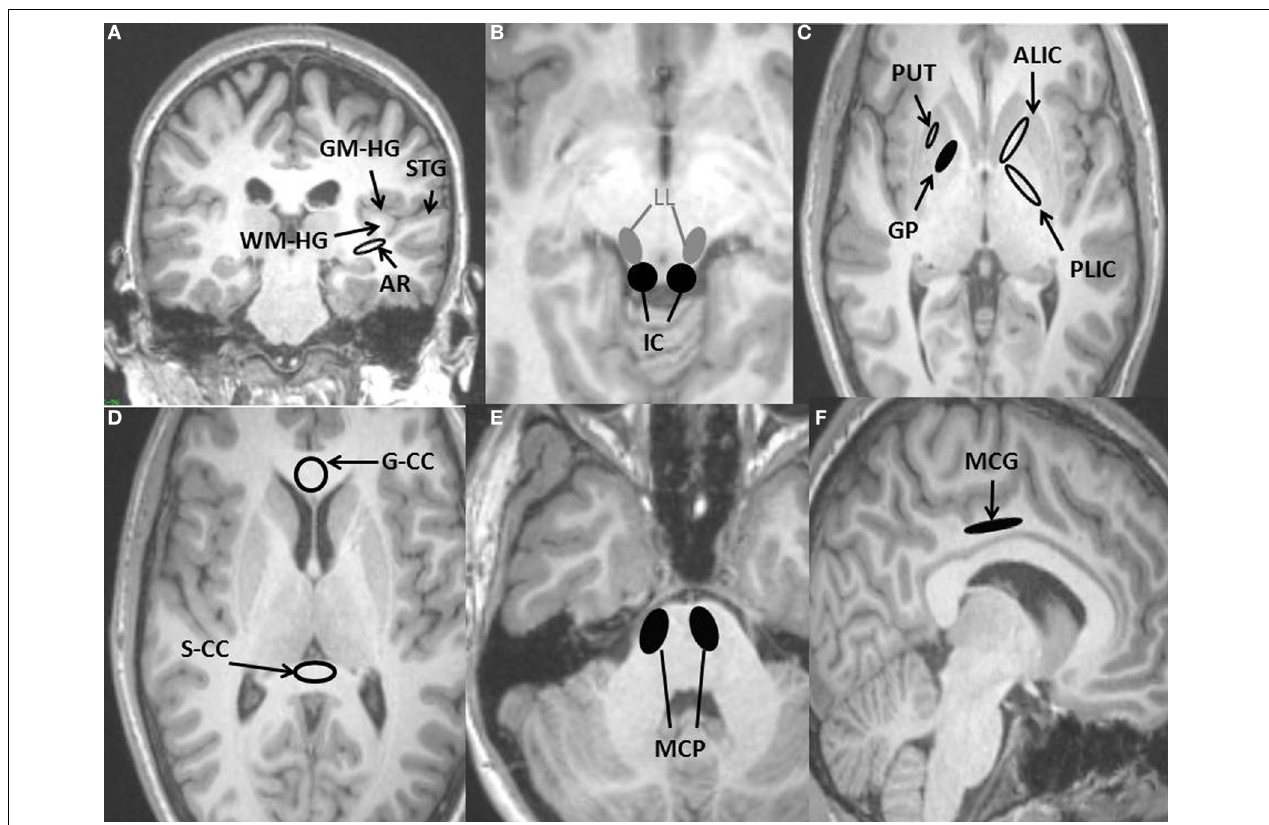
FIGURE 1 | Regions of interest (ROIs) used for DTI measurements placed on anatomical T1-weighted MRI scan. (A) Four auditory ROIs, Gray matter of Heschl’s gyrus (GM-HG), White matter of Heschl’s gyrus (WM-HG), Superior temporal gyrus (STG), and Auditory radiation (AR). (B) Two auditory ROIs, Inferior colliculus (IC), Lateral lemniscus (LL). (C) Three